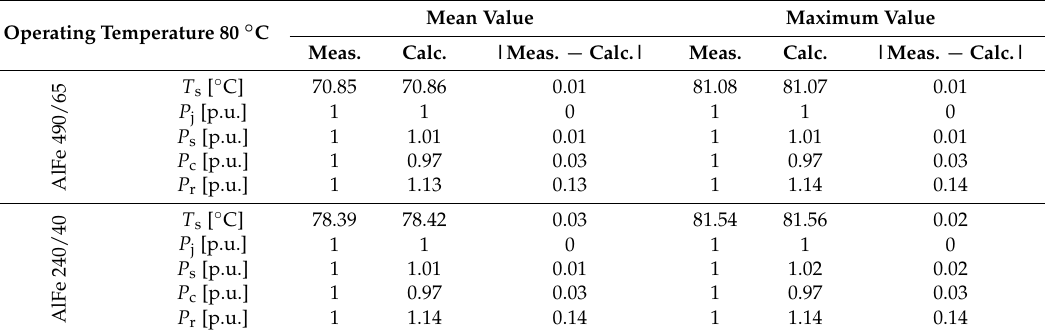
Table 12. Measured (meas.) and model-calculated (calc.) mean and maximum values of the conductor temperature, heating and cooling powers (per unit values) for conductors AlFe 490/65 and AlFe 240/40 at 80 ◦ C after